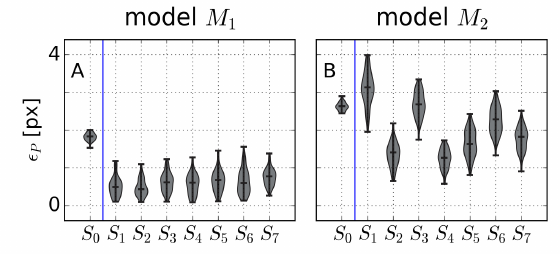
Figure 5. Errors (cid:101) P for angle A 1 and models M 1 ( A ) and M 2 ( B ) as a function of the GCP calibration subset ( S 0 to S 7